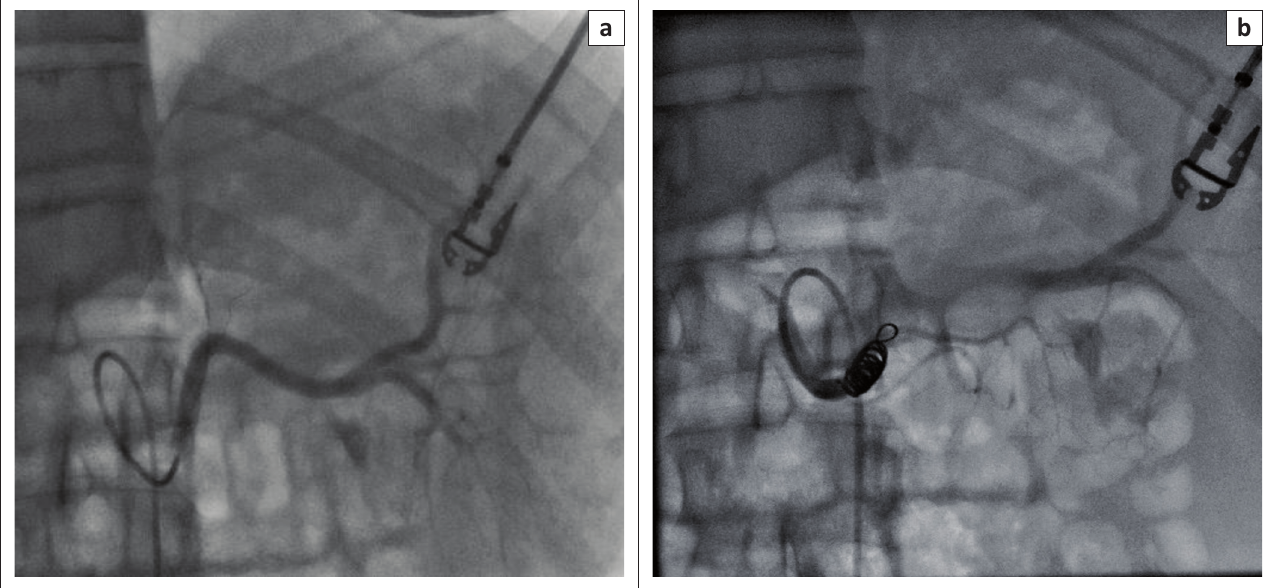
FIGURE 1: Fluoroscopic images demonstrating: (a) angiography of the main splenic artery and (b) coil embolisation of the proximal main splenic artery.